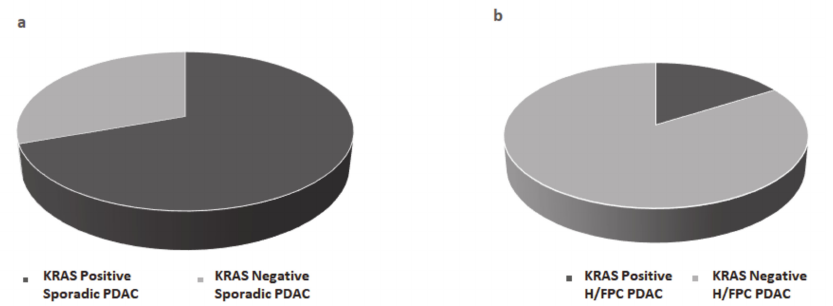
Figure 2. KRAS mutation status was determined in plasma from ( a ) sporadic PDAC cases ( b ) hereditary or familial PDAC (H/FPC) cases via BEAMing and mutant KRAS was more frequently detected in sporadic cases compared to H/FPC cases. BEAMing was performed using cfDNA isolated from 1 mL of plasma from 54 PDAC cases (31 familial cases and 23 sporadic cases). The frequency of mutant KRAS was 70% in sporadic cases and 16% in familial cases, which was statistically significant ( p ≤